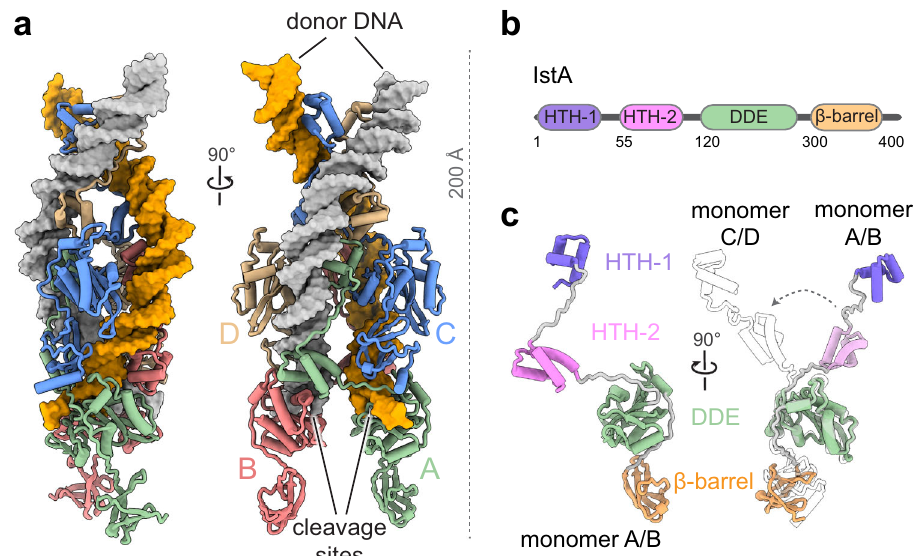
Fig.3|StructureofIstAboundtoIS 21 transposonends.a Twoorthogonalviews oftheIstAtetramerboundtotwopre-cleavedTIRDNAs. b Domainorganizationof IstA. HTH helix-turn-helix domain, DDE catalytic domain. c The transposase